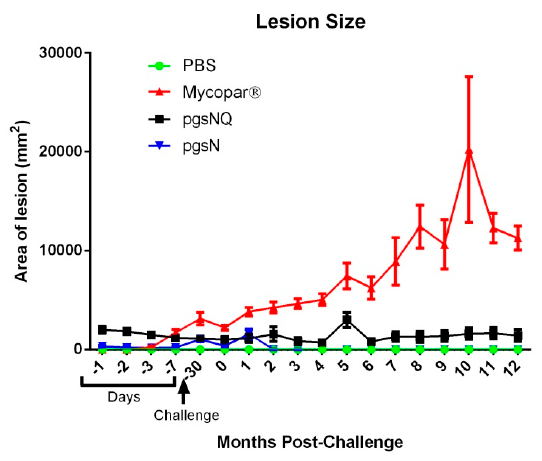
Figure 1. Safety of vaccine candidates in calves. Vaccine injection site lesions were measured throughout the duration of the study. Data are expressed as arithmetic means, with the error bars representing the standard deviation.